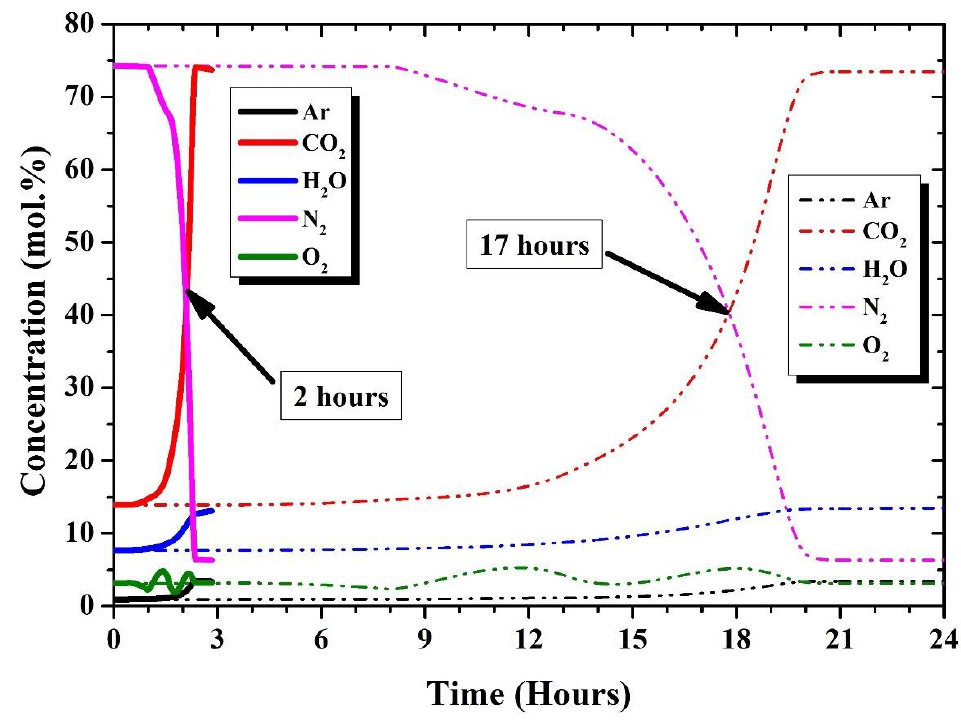
Figure 9. Comparison of primary gas components for different switching times (2 h and 17 h) from